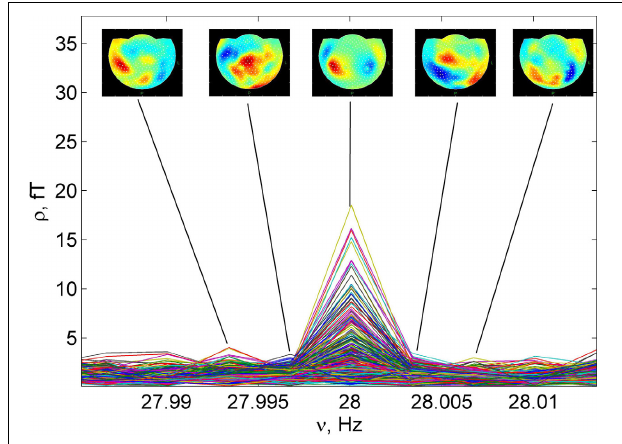
FIGURE 3 | Detail of the Figure 2B, close to the maximum of spectrum at 28Hz, (the 2nd harmonic of the stimulus). Five normalized patterns (cid:7) ρ nk (7) of the restored MEG, corresponding to neighboring frequencies, are shown.